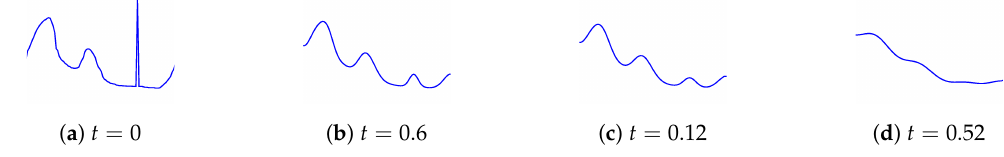
Figure 1. Heat distribution in a rod during the time